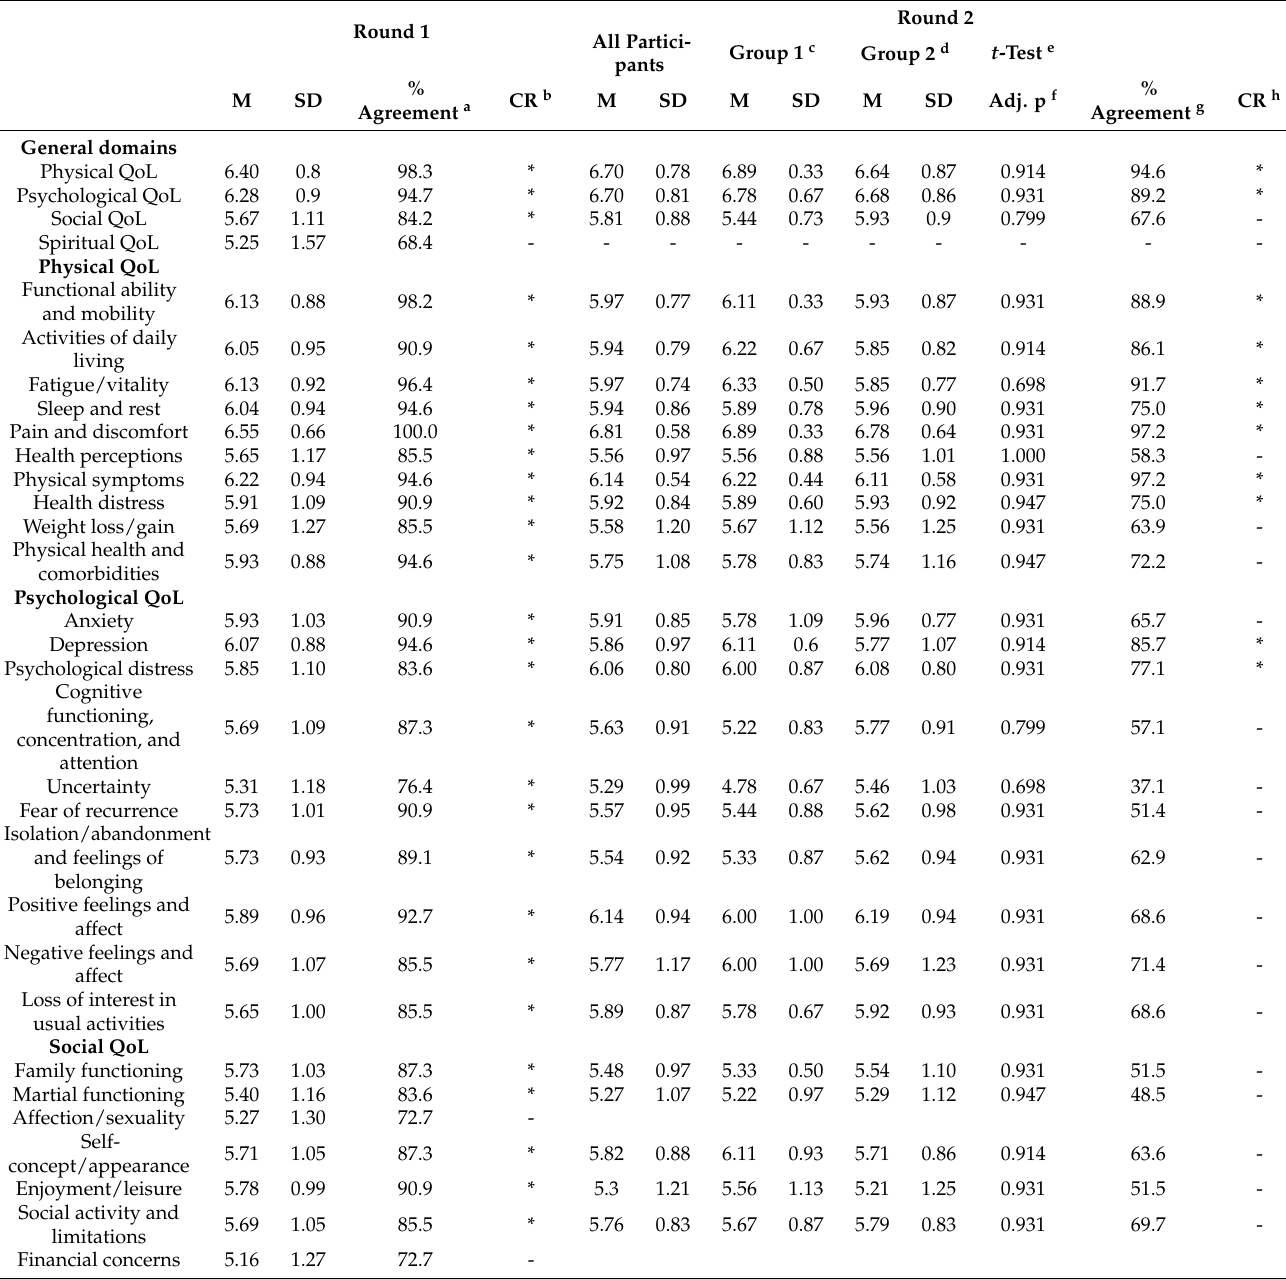
Table 2. Delphi Round 1 and 2: QoL subdomains, mean ratings with Standard Deviations, and consensus. Round 2 Round 1 All Partici- Group 1 c Group 2 d t -Test e pants